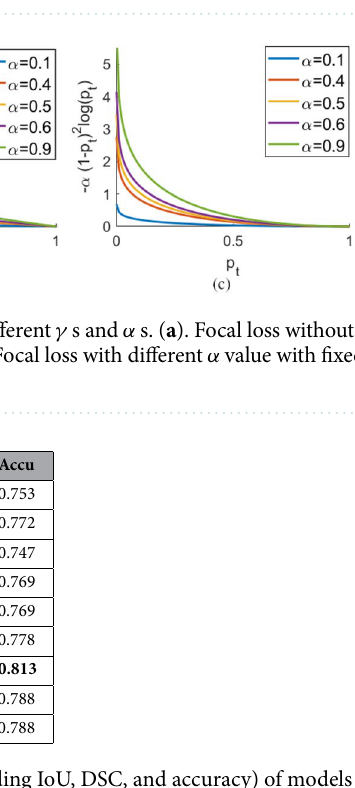
Figure 7. The time histories ( u x ) of the reference points inside the plate: ( a ) without crack, ( b ) with a generated crack.